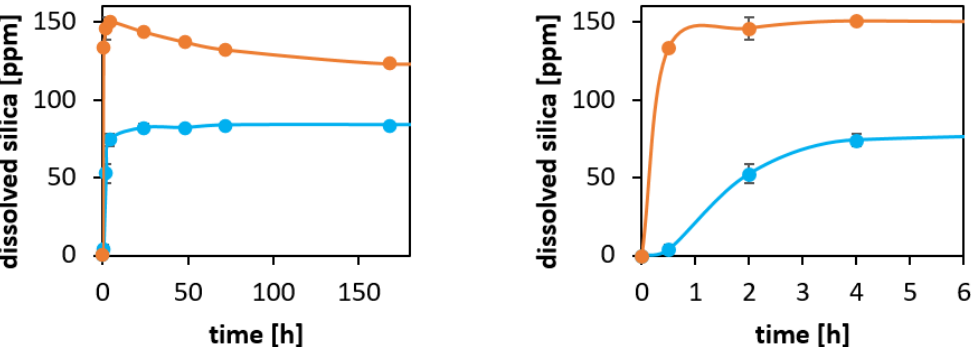
Figure 4. Left: Silicon concentrations measured by ICP-OES as a function of incubation time in PBS (pH = 7.2) at 37 °C. Orange dots: 5 mg particles/mL, blue dots: 0.1 mg particles/mL. Right: Zoom highlighting the early stages of dissolution. The lines are guides for the eye.